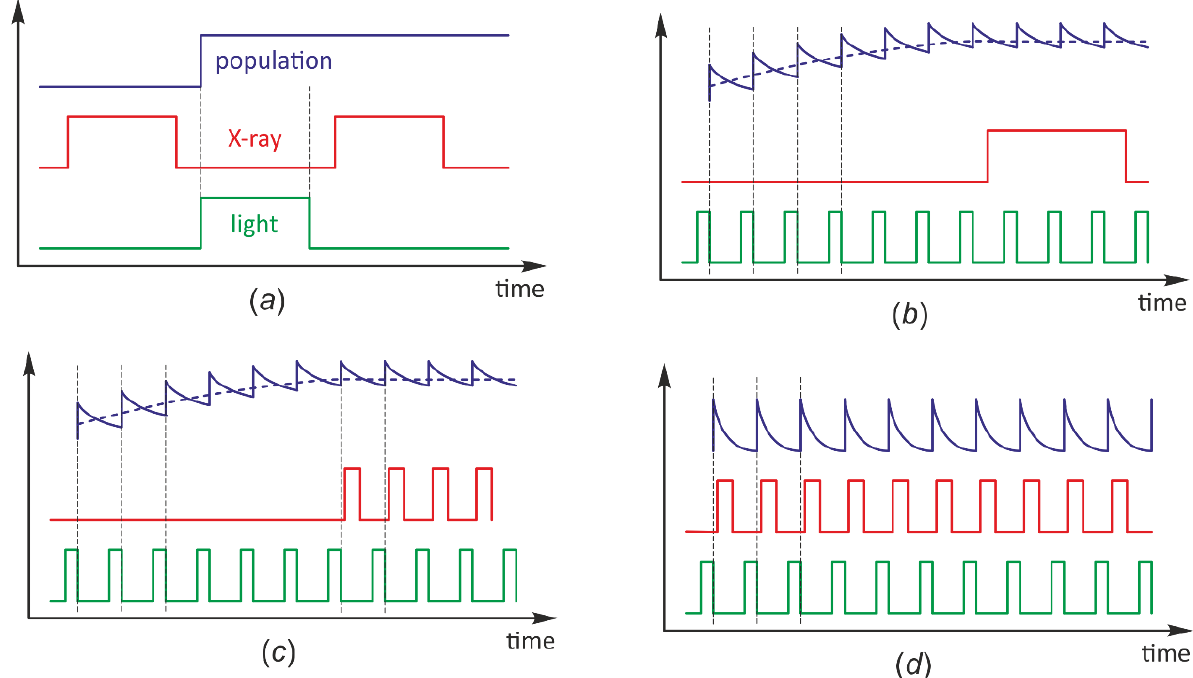
Figure 2. Schematic representation of various types of photocrystallographic experiments: ( a ) static method, ( b ) quasi-static, ( c ) stroboscopic and ( d ) pump-probe. Dashed lines in ( b , c ) refer to the average population. Note that in all cases it is assumed that the processes are reversible. Figure based on Hatcher and Raithby [15].